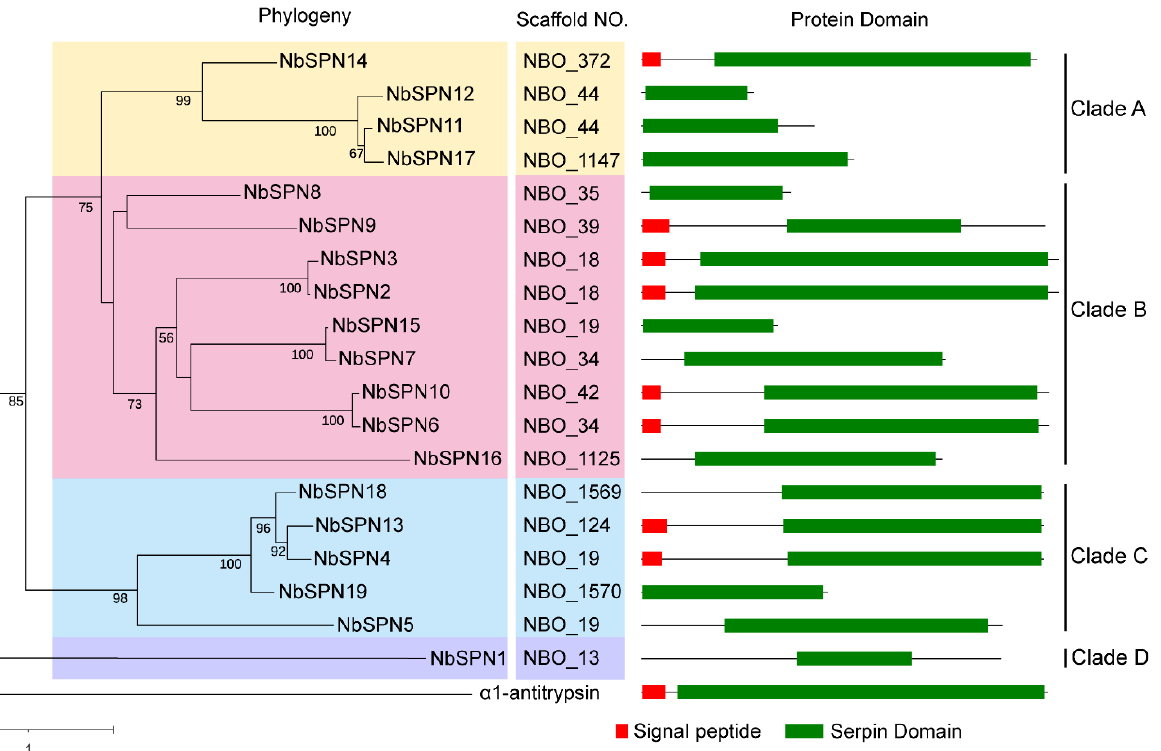
Figure 4. Phylogenetic analysis of NbSPNs and Protein Domain. The neighbor-joining phylogenetic tree was based on serpin protein sequences using MEGA-X. The archetypal serpin α1 -antitrypsin was used as the out group. The different colors are to highlight the branches. Serpins with the predicted signal peptides (SignalP-5.0 Online: https://services.healthtech.dtu.dk/service.php?SignalP-5.0, accessed on 6 June 2022) are labeled with a red square.